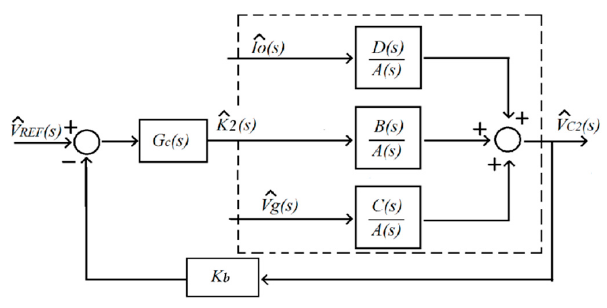
Figure 13. Block diagram of the output voltage regulation loop.